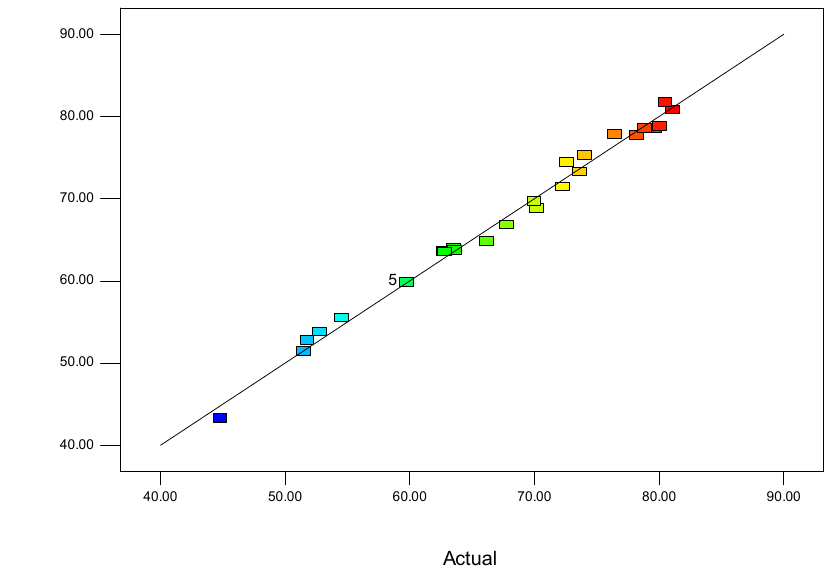
Figure 8. Normal plot of studentized residuals versus normal percent probability.